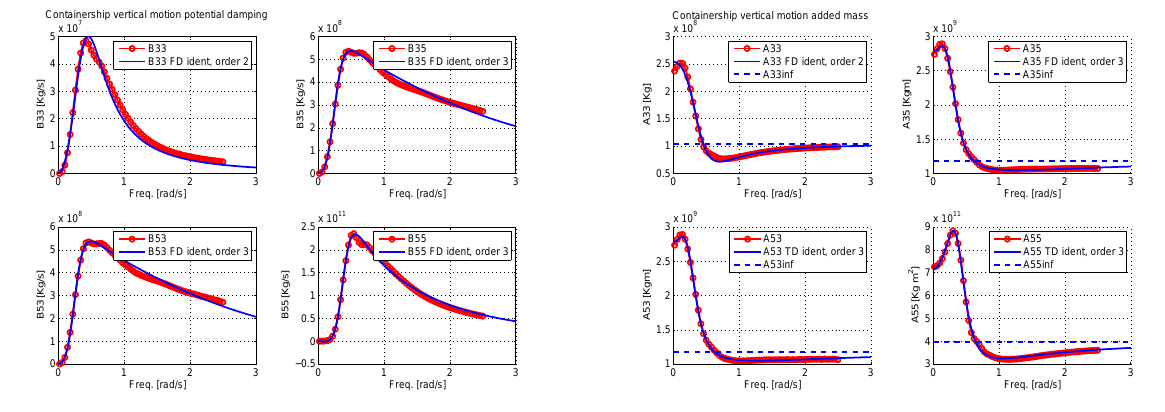
Figure 12: Reconstruction of potential damping from the real part of ˆ K 33 ( jω ) based on frequency- domain curve fitting.